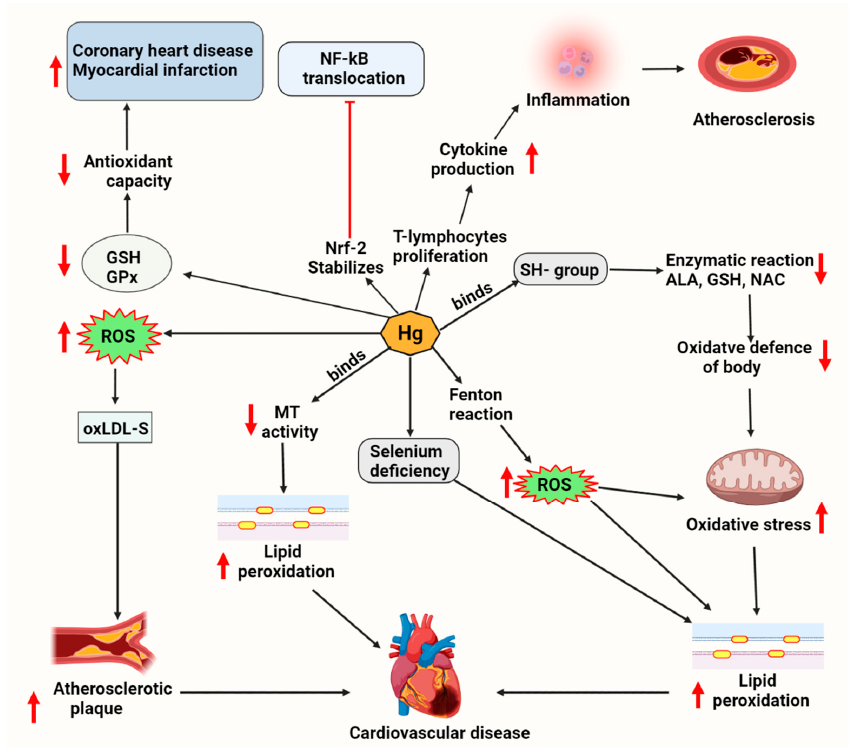
Figure 3. Mercury-induced lipid deregulation and cardiotoxicity. Mercury generates ROS through the Fenton reaction, which increases oxidative stress in the cell, increases lipid peroxidation, and causes metallothionein and selenium deficiency. Mercury compounds also decrease antioxidant levels and further causes inflammation, leading to cardiovascular dysfunction. Abbreviations: ALA, alpha-lipoic acid; GPx, Glutathione peroxidase; GSH, reduced glutathione; MT, metallothionein; NAC, N-acetylcysteine; Nfr-2, nuclear factor erythroid 2–related factor 2; NF-kB, nuclear factor-kappa B; oxLDL, oxidized low-density lipoprotein; ROS, reactive oxygen species; SH, sulfhydryl group.